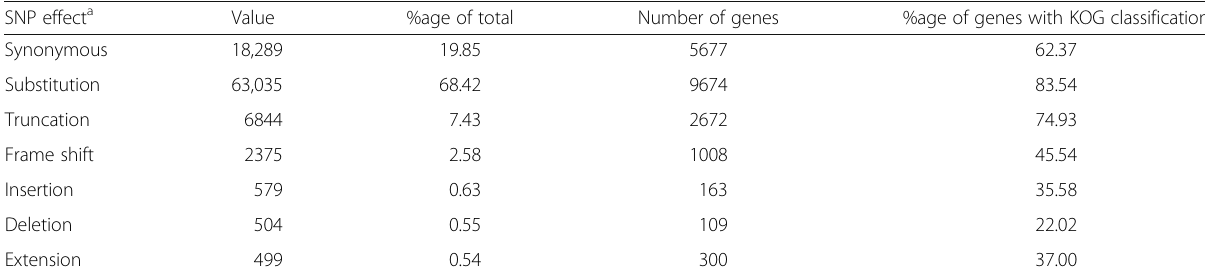
Table 6 SNPs identified between sample MixIX and Diuraphis noxia biotype